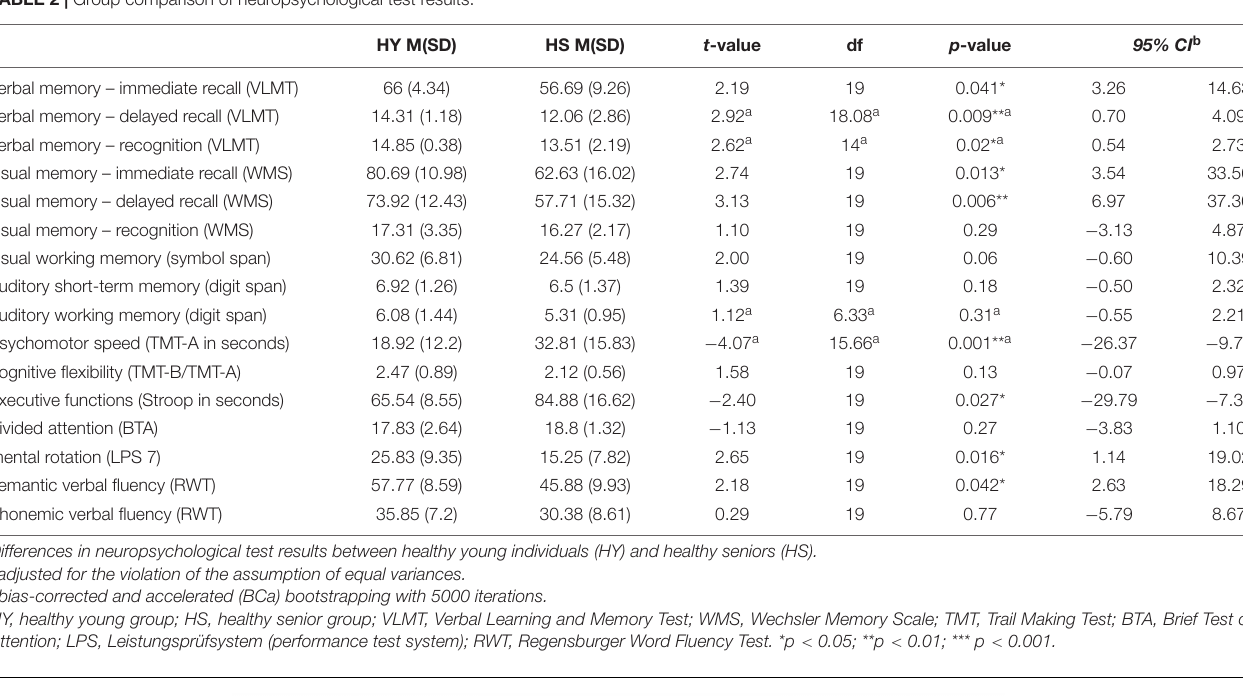
TABLE 2 | Group comparison of neuropsychological test